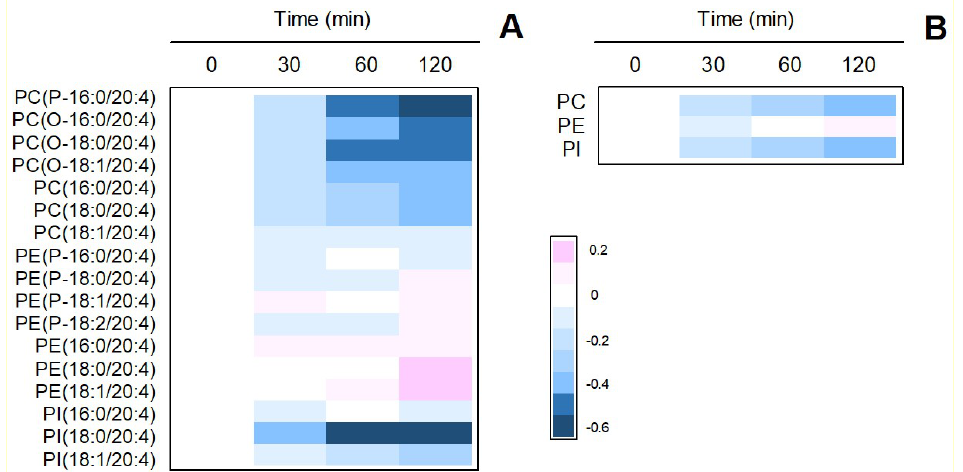
Figure 3. Time-dependent changes of AA-containing phospholipid species in zymosan-stimulated macrophages. ( A ) The cells were stimulated with 1 mg/ml zymosan for the times indicated. The figure shows a heat map of all species identified by LC/MS. ( B ) Sum of AA-containing species within phospholipid classes. The phospholipids are designated according to Fahy et al. [59]. Fatty chains within the different phospholipid species are designated by their number of carbons followed by a colon, and the number of double bonds. A designation of O- before the first fatty chain indicates that the sn-1 position is ether linked, whereas a P- designation indicates a plasmalogen form (sn-1 vinyl ether linkage). Phospholipids containing two ester bonds have no designation. The experiment shown is representative of three independent determinations with duplicate incubations.